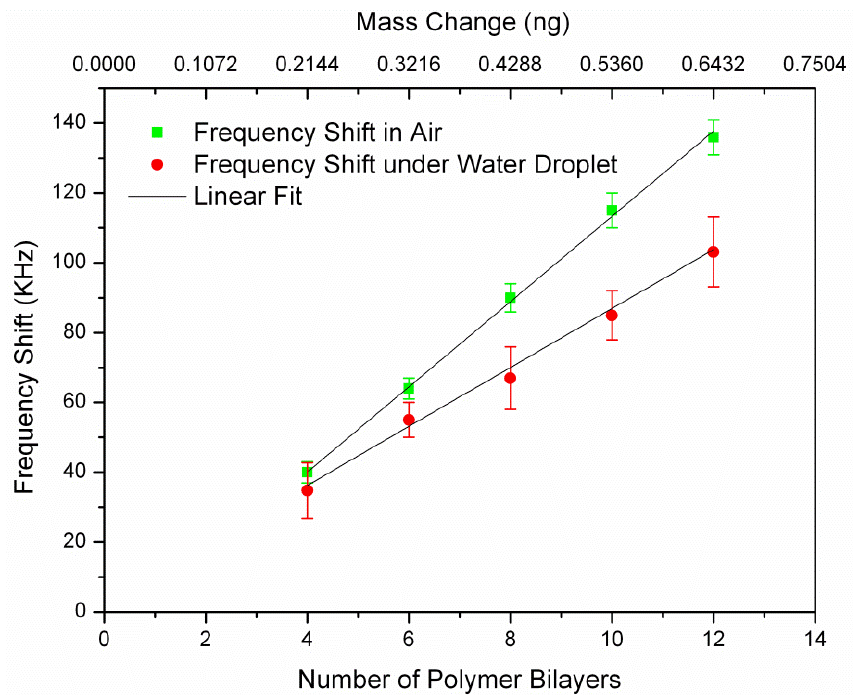
Figure 5. Absolute frequency shift, versus number ofcoated PEMbilayers and its corresponding mass change for the